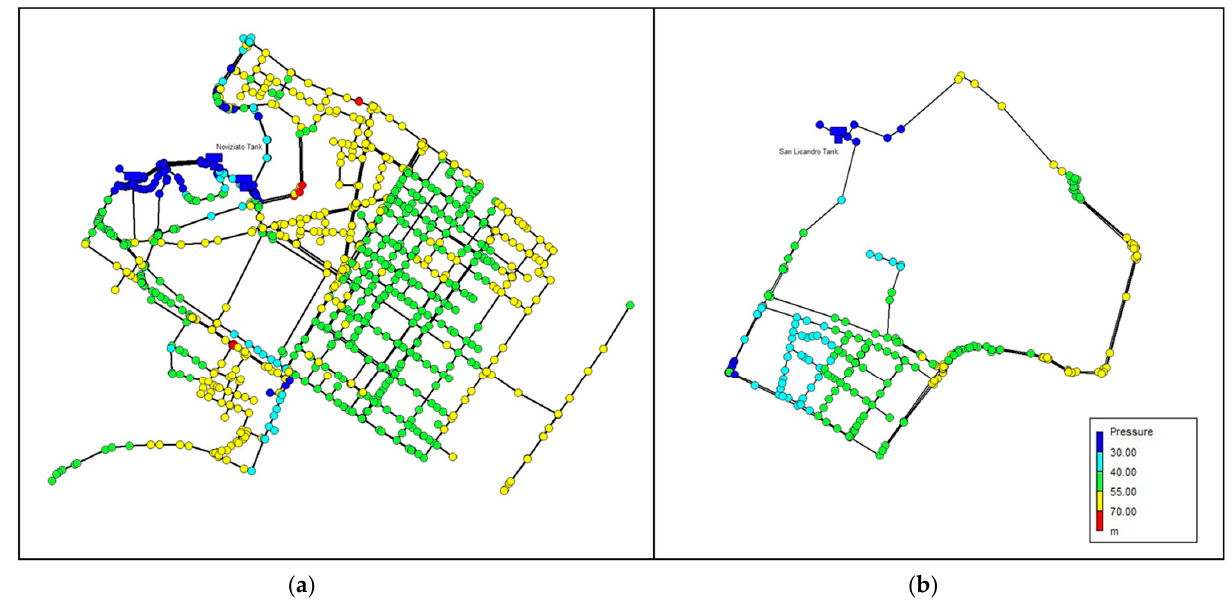
Figure 6. NPR for Messina WDN in Scenario 3 for the following districts: ( a ) Noviziato; ( b ) San Licandro. Table 4. SI values for the district with PRV in Scenario